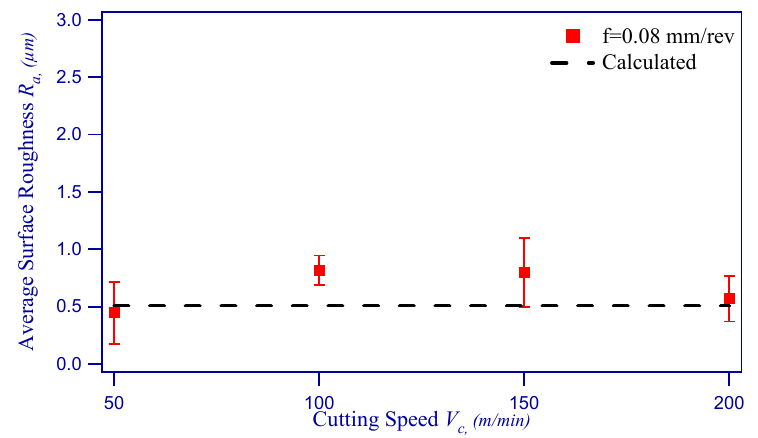
Figure 10. Surface roughness of finish-machined SLMed 316L stainless steel as a function of cutting speed.